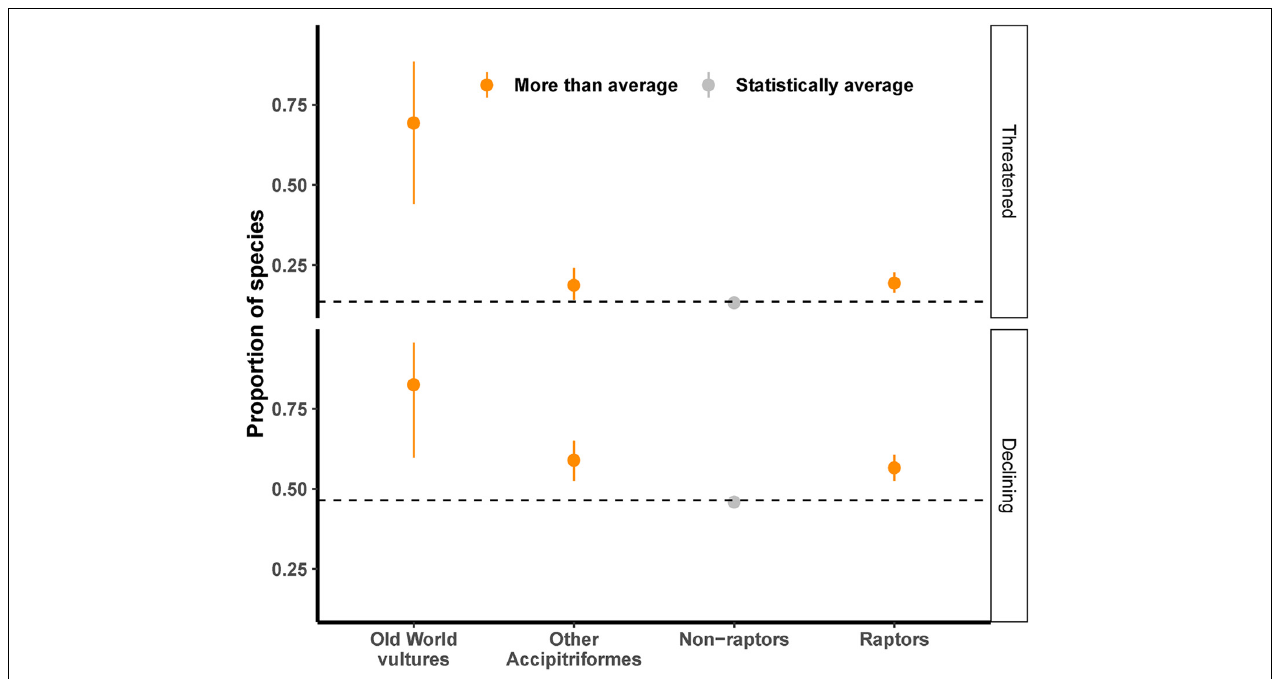
FIGURE 4 | Median (points) and 95% CRI (lines) of proportions of threatened and declining species per group of birds. Horizontal dashed lines represent the Class-wide proportion (i.e., Orders are more than average (orange) if the 95% CRI of the difference between the order’s proportion and the average is negative).